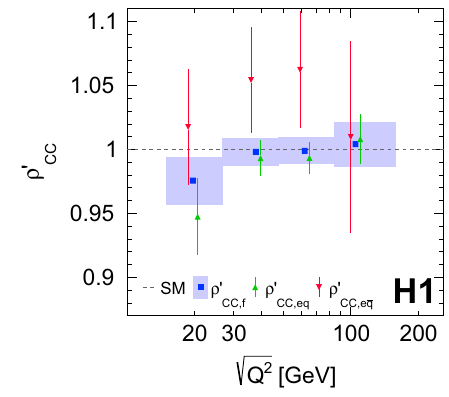
Fig. 8 Values of the ρ (cid:6) parameters determined for four different val- CC ues of Q 2 . The error bars, as well as the height of the shaded areas, indicate the total uncertainties of the measurement. The width of the shaded areas indicates the Q 2 range probed by the selected data. The values for the ρ (cid:6) and ρ (cid:6) parameters are horizontally displaced CC , eq CC , e ¯ q for better